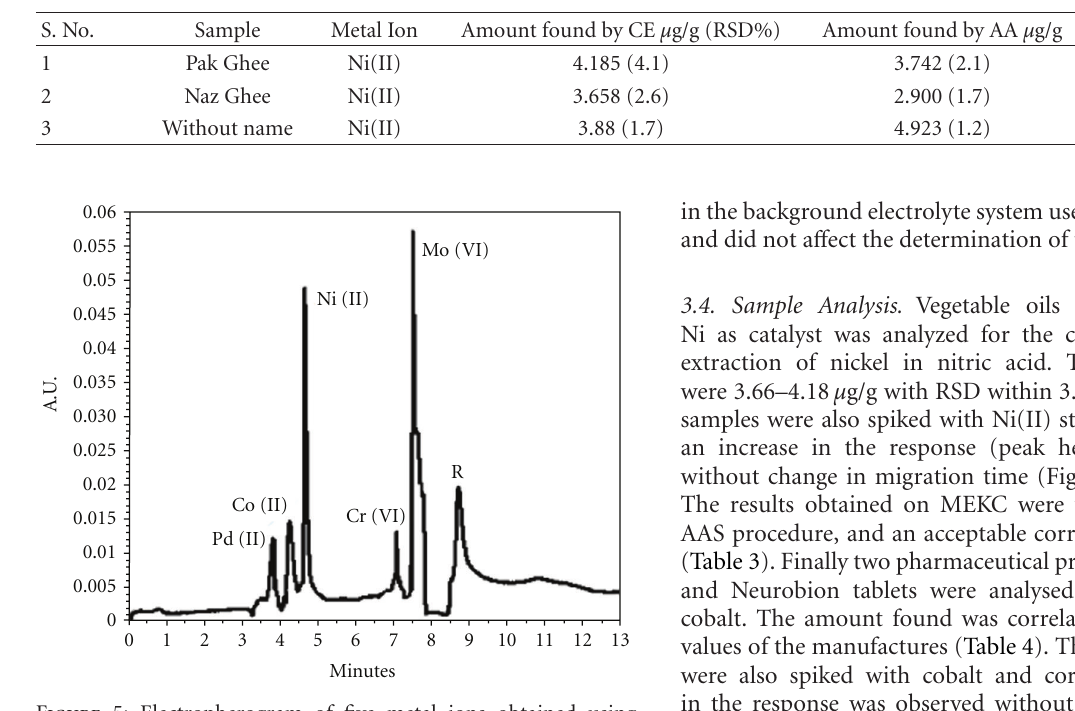
Table 3: Amount of Ni(II) present in hydrogenated Ghee samples.